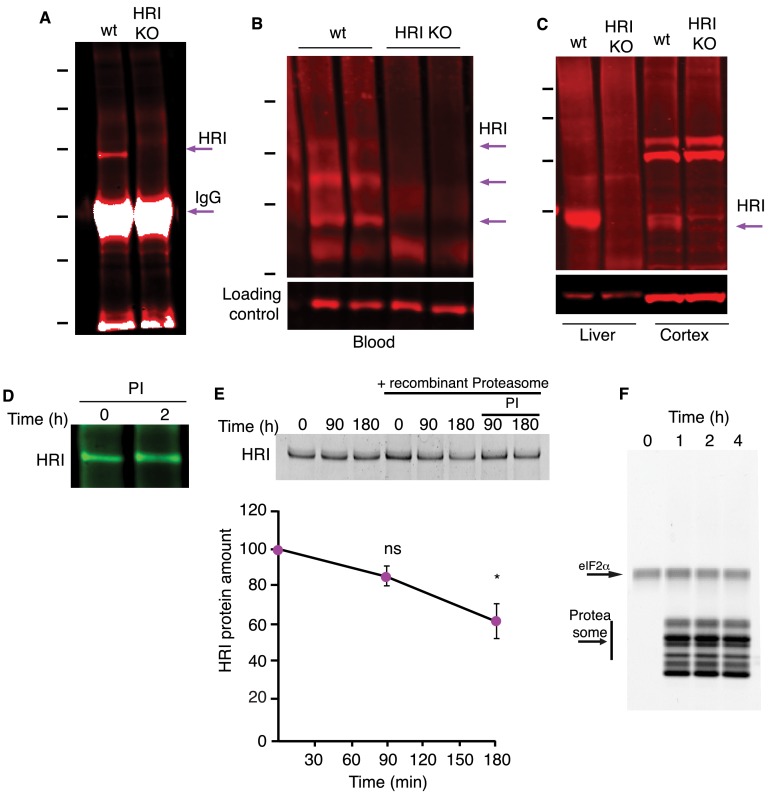
Additional data on HRI expression following proteasome inhibition.(A) Validation of the HRI antibody in cultured neurons showing a distinct band present at 75 kD, (MW of HRI ≈ 75kD) after IP and the absence of the band in cultured neurons prepared from an HRI knock-out mouse. Molecular weight markers from top-to-bottom are 150, 100, 75, 50, 37 and 25 kD. (B) HRI is expressed at significant levels in blood. Arrows point to three different apparent HRI variants present in WT and absent in HRI KO. Molecular weight markers from top-to-bottom are 150, 100, 75 and 50 kD. (C) HRI expression in liver and cortex. Molecular weight markers from top-to-bottom are 250, 150, 100, and 75 kD. (D) Western blot demonstrating the modest but significant stimulation of HRI protein expression following a 2hr MG132 (10 μM) treatment. The analysis of this representative experiment and other experiments is shown in Figure 4B. (E) In vitro degradation experiment in which recombinant HRI was added to recombinant 20S proteasome for the indicated times. The graph indicates the recombinant proteasome-dependent degradation of HRI, obtained by subtracting the amount of HRI degradation that occurred with the addition of the recombinant proteasome together with a proteasome inhibitor (‘proteasome-independent degradation’). Plot shows analysis of the HRI protein degradation by the recombinant 20S proteasome normalized to control reactions without proteasome. Control vs. 90 min, p>0.05, 0 vs 180 min p≤0.05, two experiments. Error bars = SD. (F) Control experiment for that shown in (E) showing that eIF2α, as one example, is not a proteasome substrate in this assay.Figure 4—figure supplement 1—source data 1.Source data for Figure 4—figure supplement 1E.Figure 4—figure supplement 1—source data 2.Source data for Figure 4—figure supplement 1A, B, C, D, E, F.